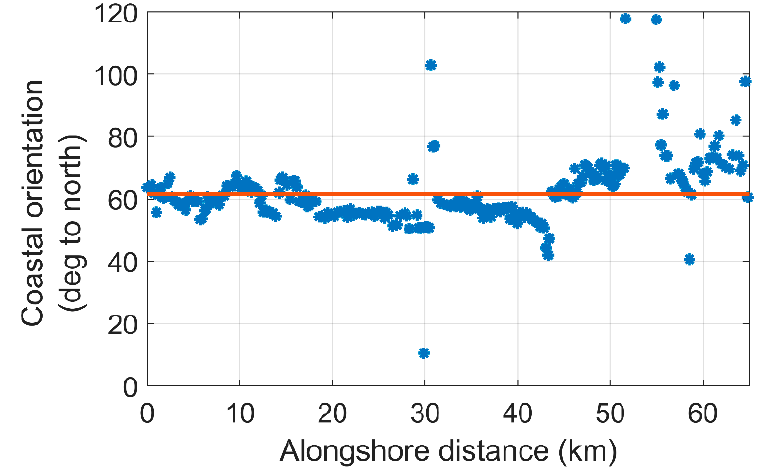
Figure 2. Coastal orientation of the Belgian coast. It represents the orientation of dunes or dykes. The mean coastal orientation is 62° with respect to the north (red line).